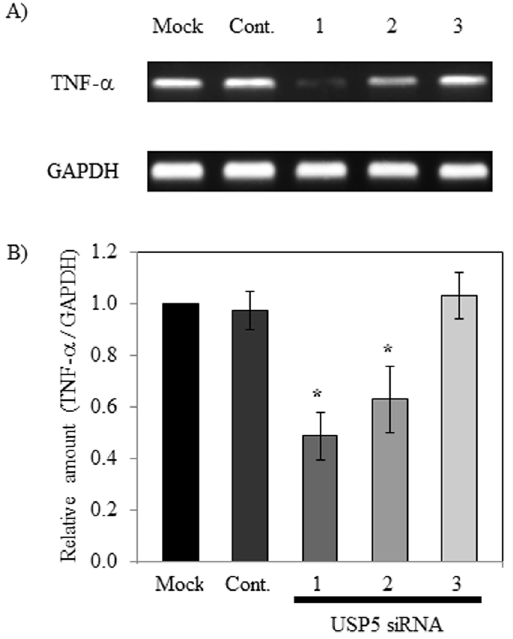
Figure 4. Expression of TNF- a mRNA in USP5 siRNA-knock- down cells. (A) Expression of TNF- a mRNA in RBL-2H3 cells treated with USP5 siRNAs were analyzed by real-time RT-PCR. PCR products were detected with agarose gel electrophoresis. (B) Band intensities of PCR products were measured and compared to GAPDH. The GAPDH expression pattern in RBL-2H3 cells was used as an internal control. The significance of differences from control values was calculated using the Student’s t-test (*p ,